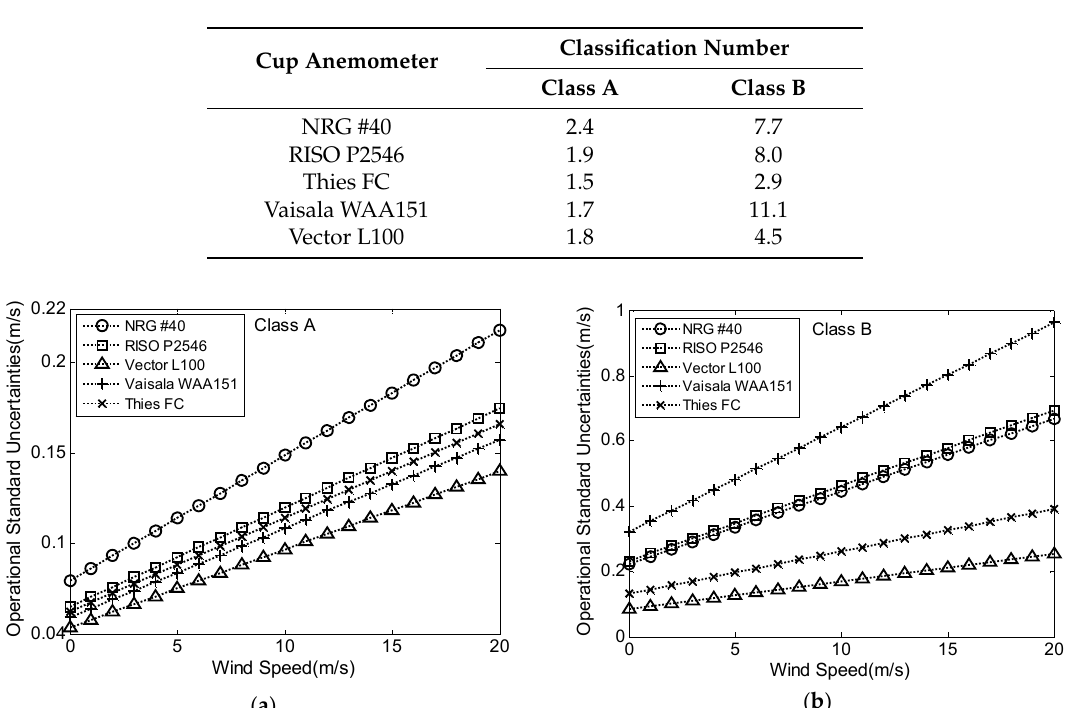
Table 2. Classification number of five popular anemometers.